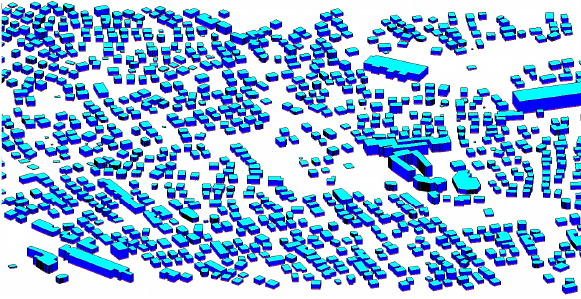
Figure 6: 3D prismatic models